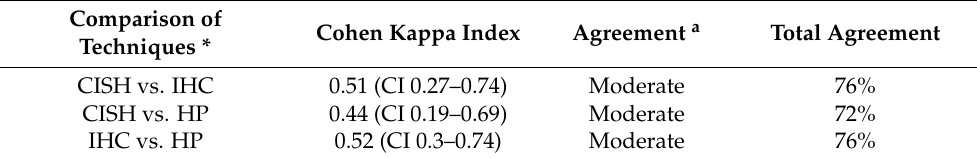
CISH: colorimetric in situ hybridization; IHC: immunohistochemistry; HP: histopathology; CI: 95% confidence interval; vs: versus; * considering the data by observer 1. a Level of agreement according to Landis and Koch.